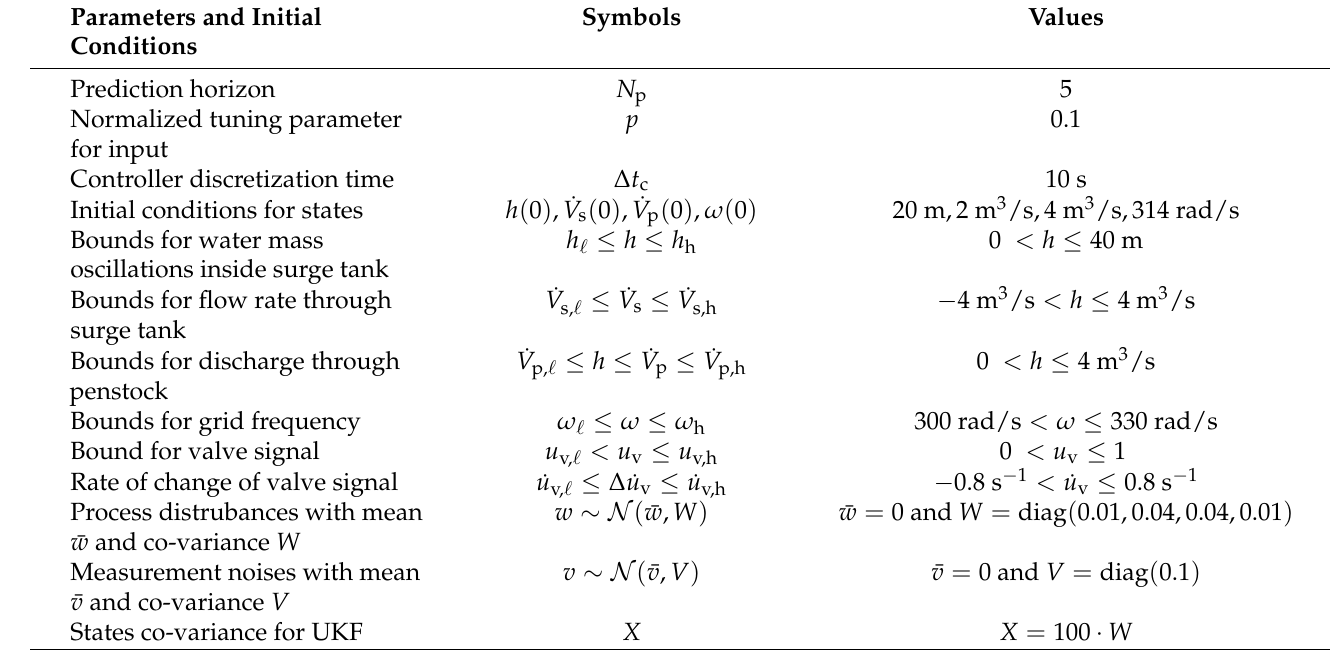
Figure 8. Grid frequency and turbine valve signal for different controller discretization time. The actual continuous solution of the turbine valve signal for specific discretization time is found using time = k ∆ for k ∈ [ 1,1000 ] . Hence, readers should t c not compare results based on amplitude only. Table 2. Controller